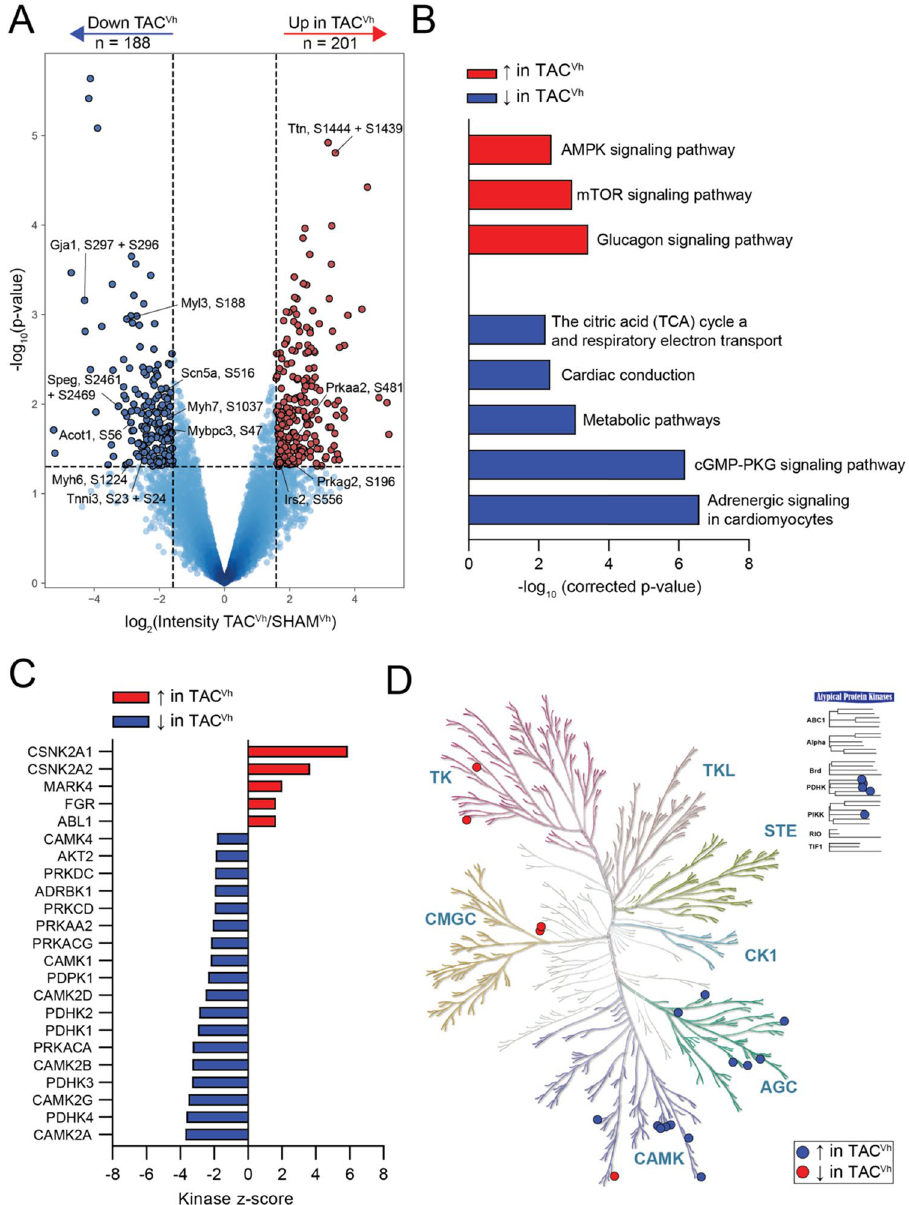
Figure 3. Phosphorylation mediated signaling changes in response to heart failure. Analyses of phosphorylated peptide intensities from TAC Vh versus SHAM Vh animals. ( A ) Volcano plot analysis showing phosphorylated peptides that are either downregulated (blue) or upregulated (red) in heart failure animals compared to controls. ( B ) Functional enrichment analysis of proteins with either upregulated (red) or downregulated (blue) phosphorylation sites in TAC Vh compared to SHAM Vh evaluated based on KEGG 68–70 and REACTOME pathway analyses. ( C ) Kinase-Substrate Enrichment Analysis results that show kinases with either up- (red) or downregulated (blue) activity in the TAC Vh hearts compared to SHAM Vh hearts. ( D ) Phylogenetic tree of the kinome (KinMap 71 ), showing kinases with upregulated (red) or downregulated (blue) activities in response to heart